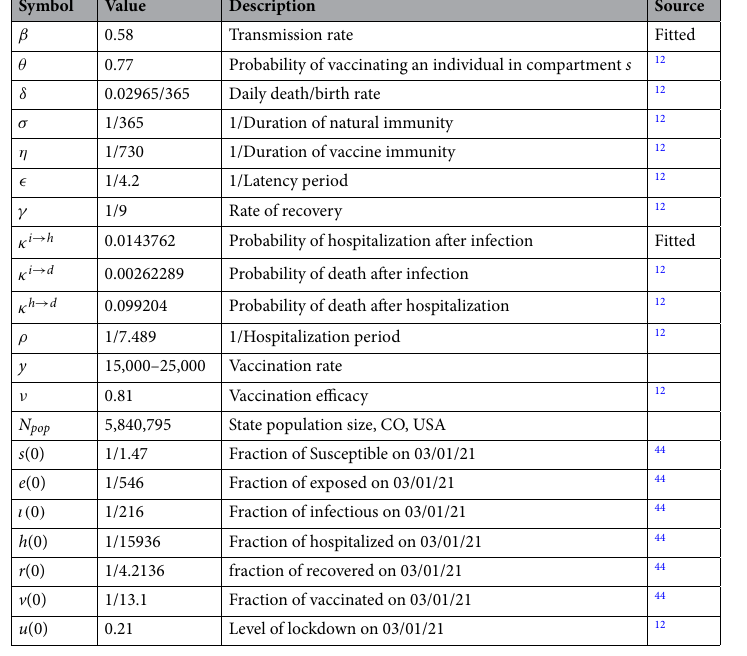
Table 1. Model parameters resulting from the model fitting